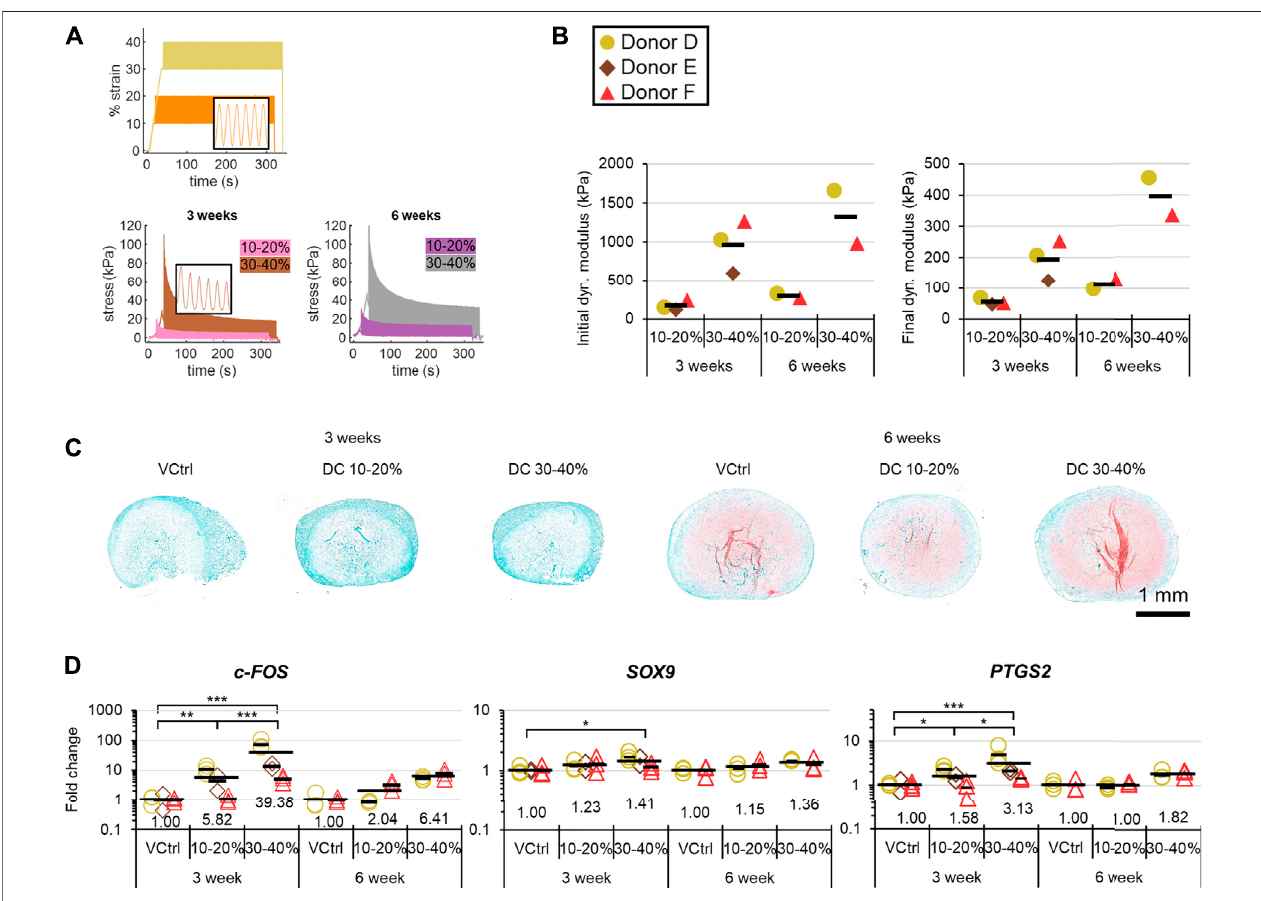
FIGURE 6 | Experiment II: The matrix and gene expression effects of pre-culture duration and strain. (A) Representative strain and stress vs time curves. (B) Mechanicalanalysis. (C) Representativesafranin-Ostainingafterloadingineachgroup. (D) Geneexpressionpost-DCloadingbyqRT-PCR.Foldchangesarerespectto the VCtrl group within each time point within each donor, and values for each gene of interest are normalized to the mean expression of housekeeping genes β -actin , B2M ,and YWHAZ .Expressionwasmeasured30 minaftertheloadingevent.Analysisofvariancewasrestrictedto3-weeksgroupsbecauseonlytwodonorswere available at 6 weeks. *: p < 0.05, **: p < 0.01, ***: p <